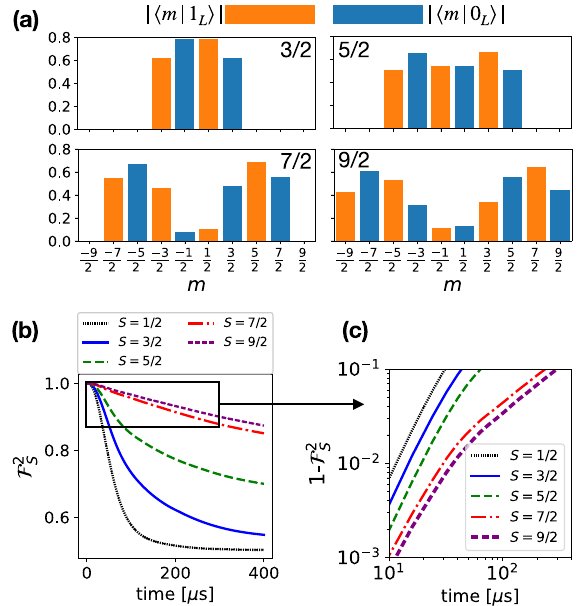
Fig. 3 Numerically optimized qudit codes. a Absolute value of the overlap of the optimized code-words 0 L j i (blue) and 1 L j i (orange) with each state m j i for different spins S . b Squared average fi delity (over nuclear con fi gurations) for different qudit spins S , for initial ffiffiffi p 2 state ψ L j i ¼ ½ 0 L j i þ i 1 L j i(cid:6) and numerical codewords 0 L j i and 1 L j i for an inset of panel ( b ) optimized at t = 5 μ s. c In fi delity 1 (cid:2) F 2 S representing the region of F 2 (cid:7) 0 : 9 . S